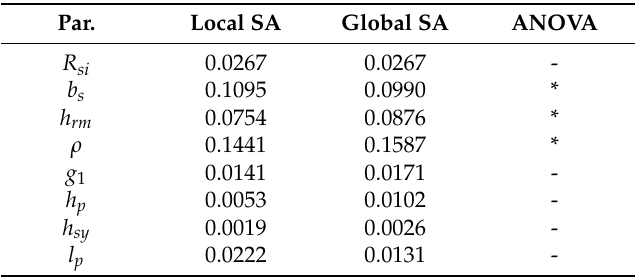
Table 4. Sensitivity analysis results for the CPM. Par. Local SA Global SA